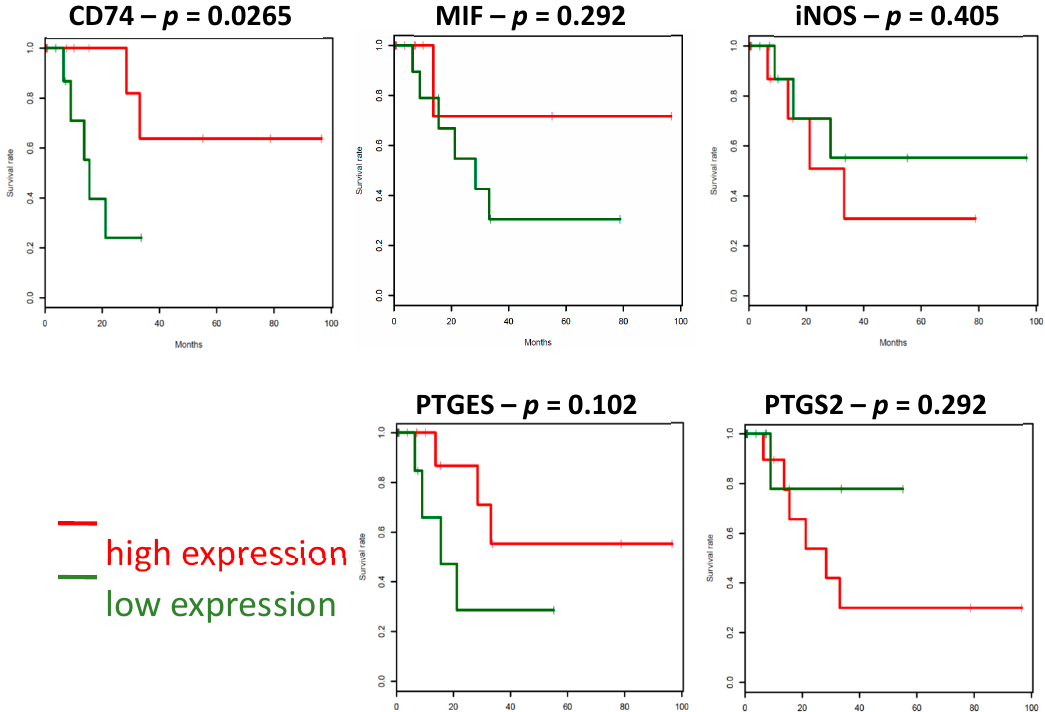
Figure 4. Survival associations in the melanoma TCGA dataset—Stage IV. Clinical outcomes by individual markers in tumor cells in stage IV melanoma patients in datasets. Kaplan-Meier analysis for OS for their expression of staining.